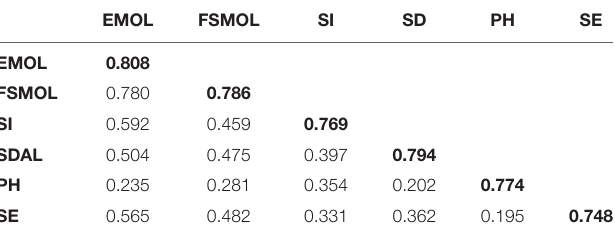
TABLE 2 | Factor loadings, reliabilities, and AVE. TABLE 3 | Fornell and Larcker